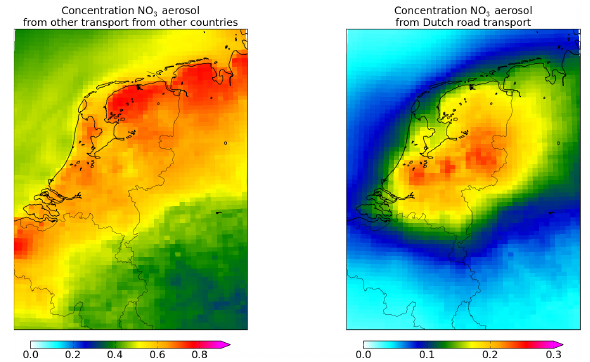
Fig. 9. Modelled source contributions of foreign non-road transport and Dutch road transport to nitrate concentrations (µgm − 3 ) across the